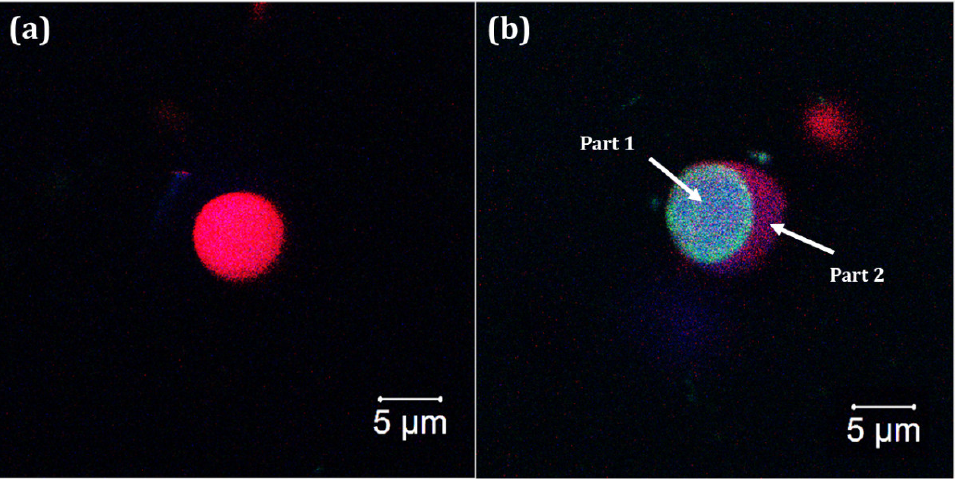
Figure 6. Confocal microscopy images of the particles from the ( a ) unloaded system and ( b ) loaded PNE system.